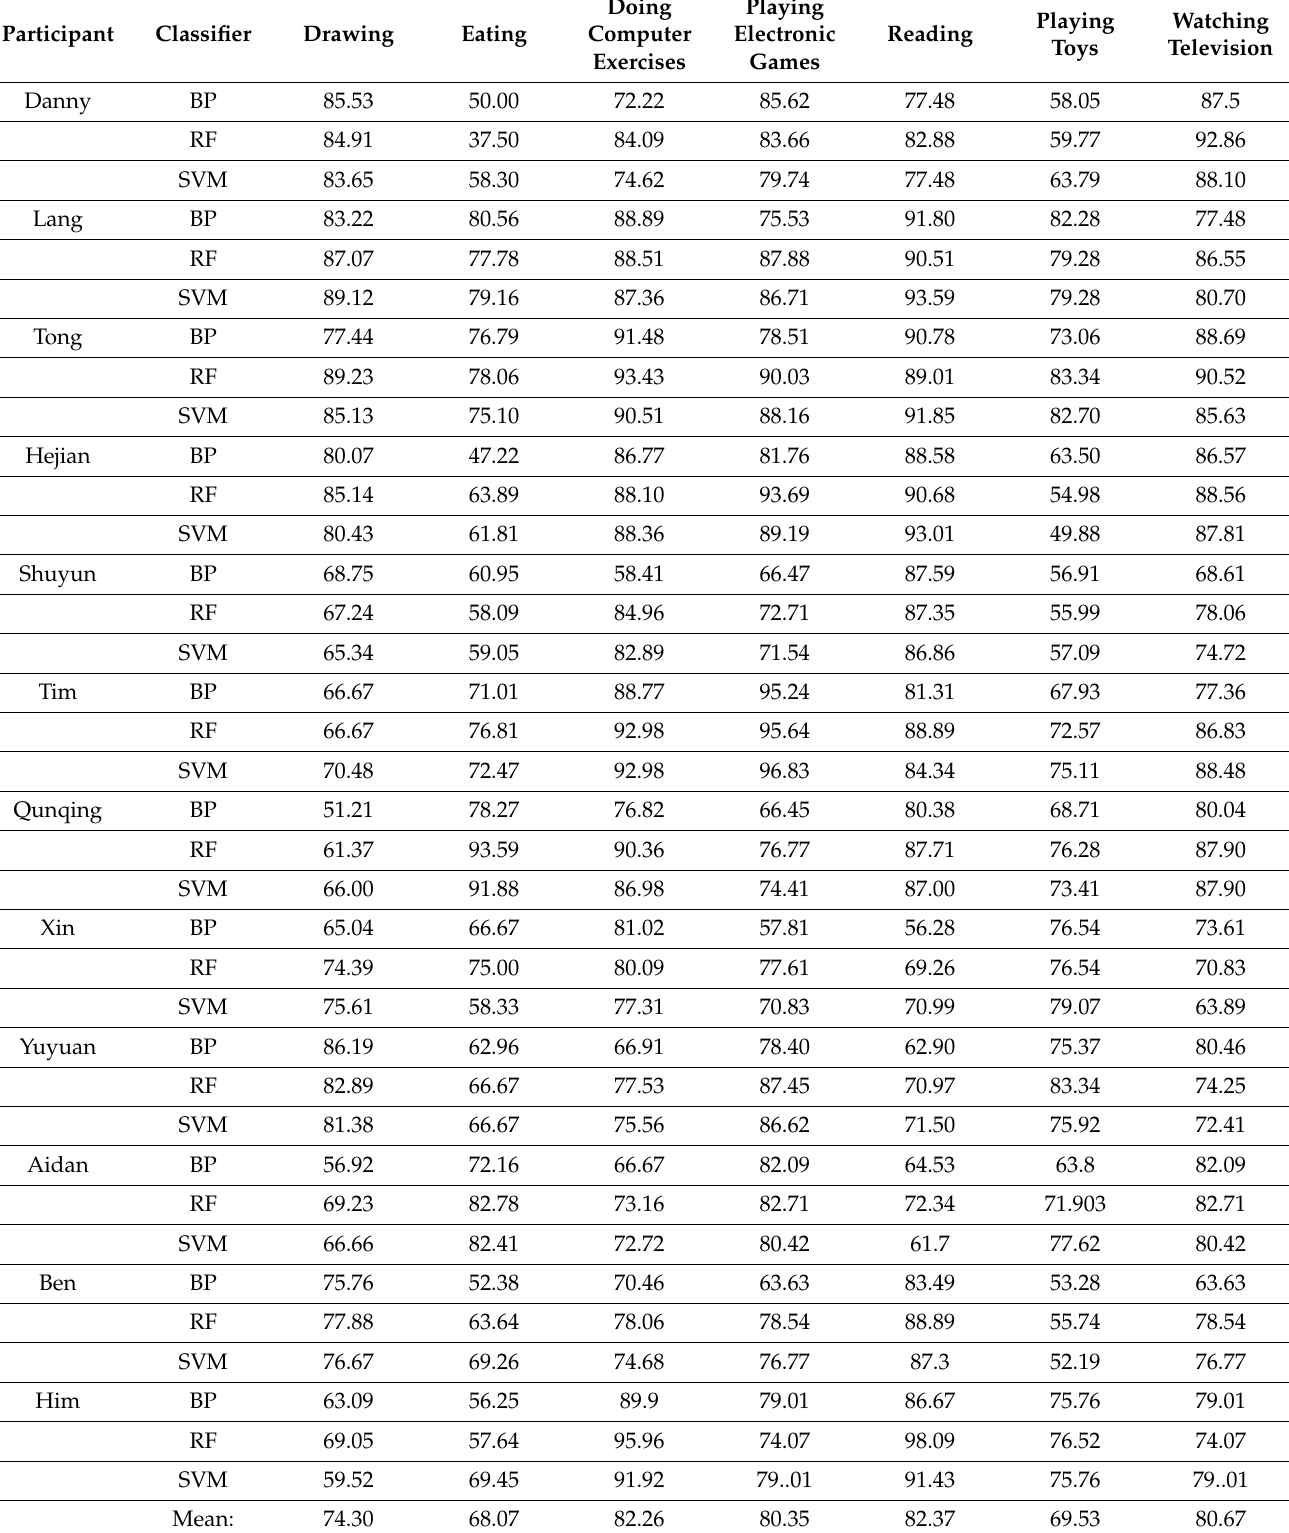
Table 5. The percentages of the classification accuracies for 12 participants performing the various activities under the concentration state yielded by the traditional